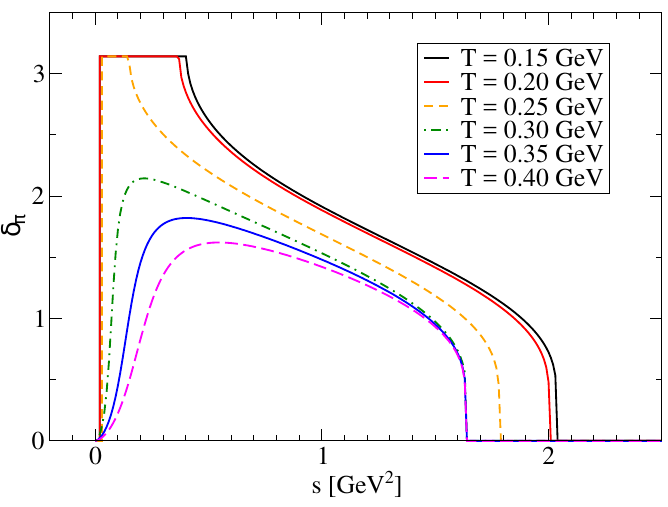
Figure 12. Phase shift of the pion as a quark-antiquark state for different temperatures, below and above the Mott dissociation temperature, from Ref.